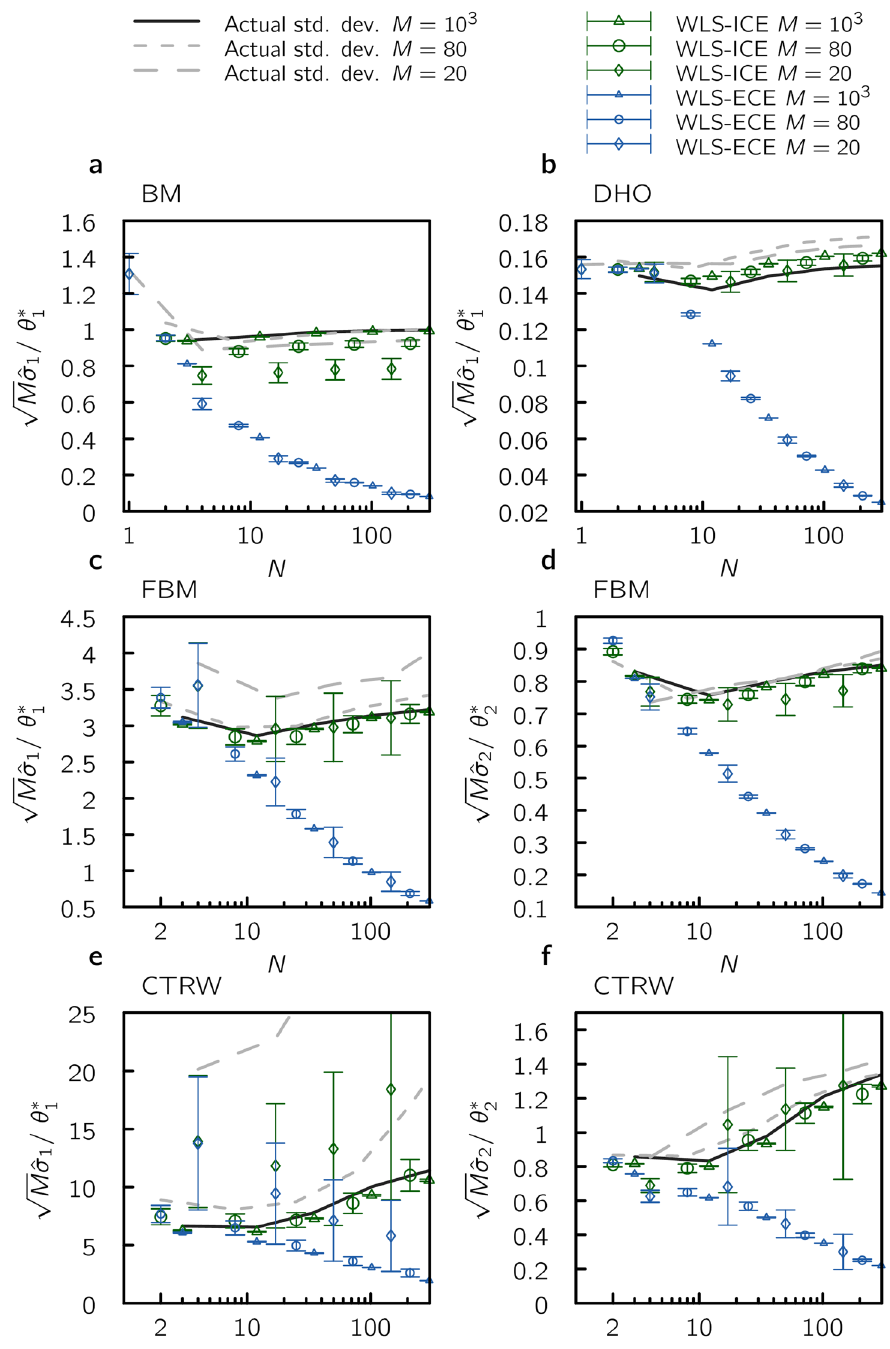
Figure 2. Error estimation. Standard deviation from the WLS-ECE and WLS-ICE parameter fits as a function of the number of sampling points, N , used in the fitting procedure (log-scale on the horizontal axis for visibility). Each method is applied to S = 500 realizations of data from ( a ) Brownian motion (BM), ( b ) damped harmonic oscillation (DHO), ( c , d ) fractional Brownian motion (FBM), and ( e , f ) continuous time random walk (CTRW). In conjunction we show the true standard deviation of each of these methods computed from the parameters from the fit (lines), i.e., the width seen in Fig. 1, but for an extended range of N . It is evident that the standard deviation from the WLS-ECE fit is far too small for almost all N . Error bars show standard error of the mean. For panels a-d there are small biases for M = 20 and M = 80 in the observable σ ˆ , as compared to actual standard deviation. These biases can be removed using the jackknife procedure applied to Equation (4b), see Section G in Supplementary Information. For panel e, M = 20, there is discrepancy between the WLS-ICE estimate σ ˆ , and the actual standard deviation; we assign this to slow convergence towards the asymptotic form for the multivariate distribution ρ (see Methods) for CTRW (see also Figure S2 in Supplementary Information). For simulation parameters, see Section D.5 in Supplementary